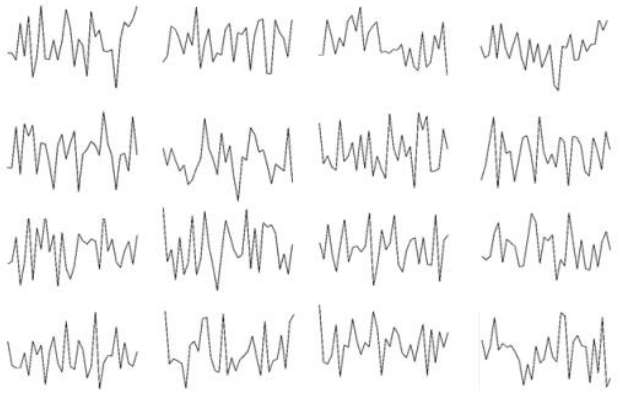
Figure 8. Sixteen convolution kernel visualizations of the first layer.